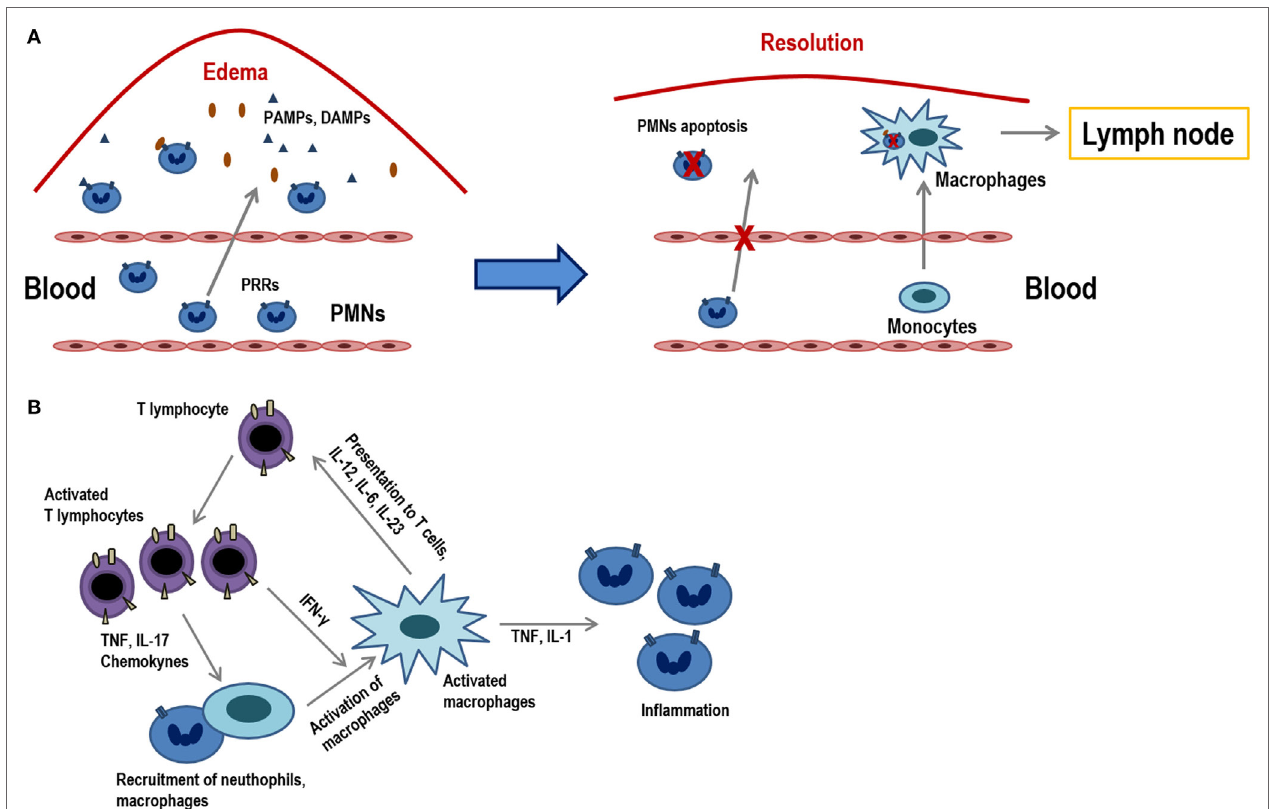
FiGURe 1 | Acute inflammation vs. chronic inflammation. (A) The onset of acute inflammation is characterized by the accumulation of polymorphonuclear neutrophils (PMNs) and monocytes that rapidly convert into tissue macrophages, as well as the appearance of edema due to damage in the inflamed tissues. Damage-associated molecular patterns and pathogen-associated molecular patterns are recognized by pattern recognition receptors (PRRs) and attract PMNs to the place of infection. PMNs represent the first line of defense in infected tissues as they eliminate much of the pathogens or harmful materials by phagocytosis. When inflammation occurs, neutrophils suffer apoptosis and they are ingested by macrophages that migrate to the lymph nodes where they will present the antigens. (B) Activated T lymphocytes produce cytokines (TNF, IL-17, chemokines) that recruit macrophages and others (IFN- γ ) which activate them. T lymphocyte subpopulations (Th1, Th2, Th17, etc.) produce diverse types of cytokines and, in turn, activated macrophages and stimulate T lymphocytes via the presentation of antigens and through different cytokines (IL-12, IL-6, IL-23). These macrophages also act on neutrophils by releasing molecules, such as TNF and IL-1.